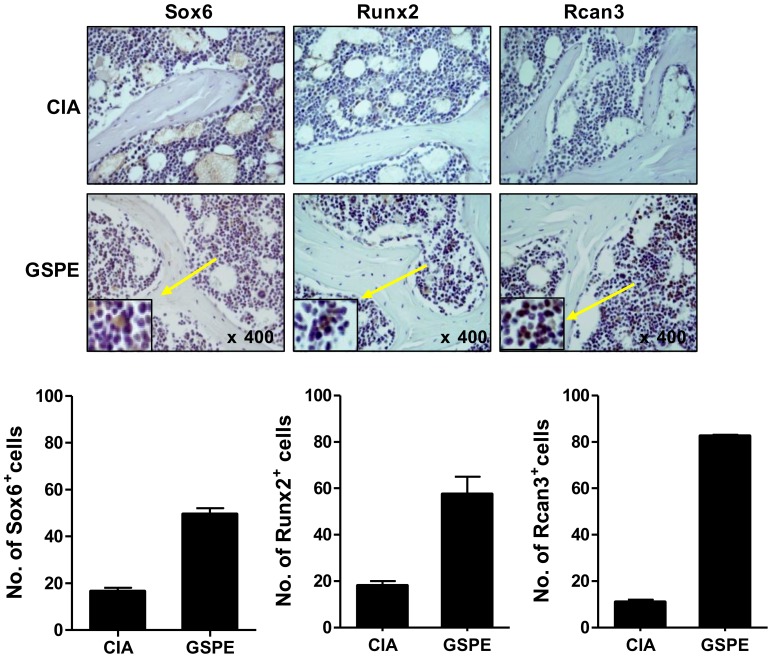
Expression of Sox6, Runx2, and Rcan3 in inflamed joints.Representative histological features of the tibiotalar joints of saline-treated CIA mice and GSPE-treated mice. Immunohistochemical staining for Sox6, Runx2, and Rcan3 is shown. Graphs represent the quantified degree of Sox6, Runx2 and Rcan3 expressed cells, respectively.